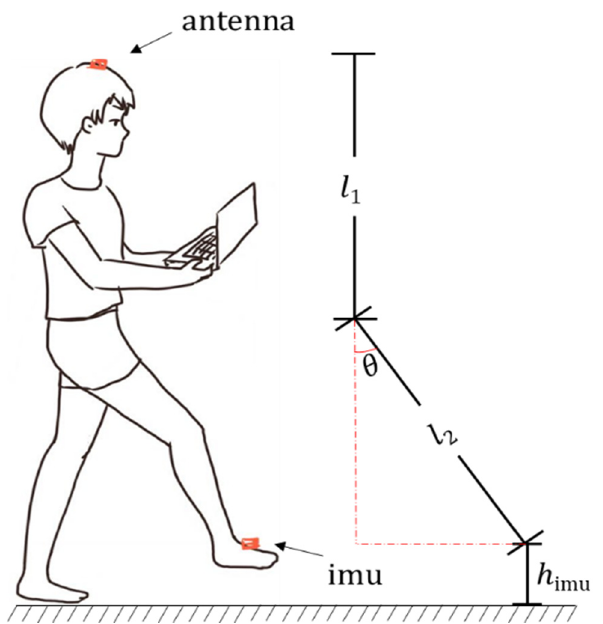
Figure 5. Lever arm model .